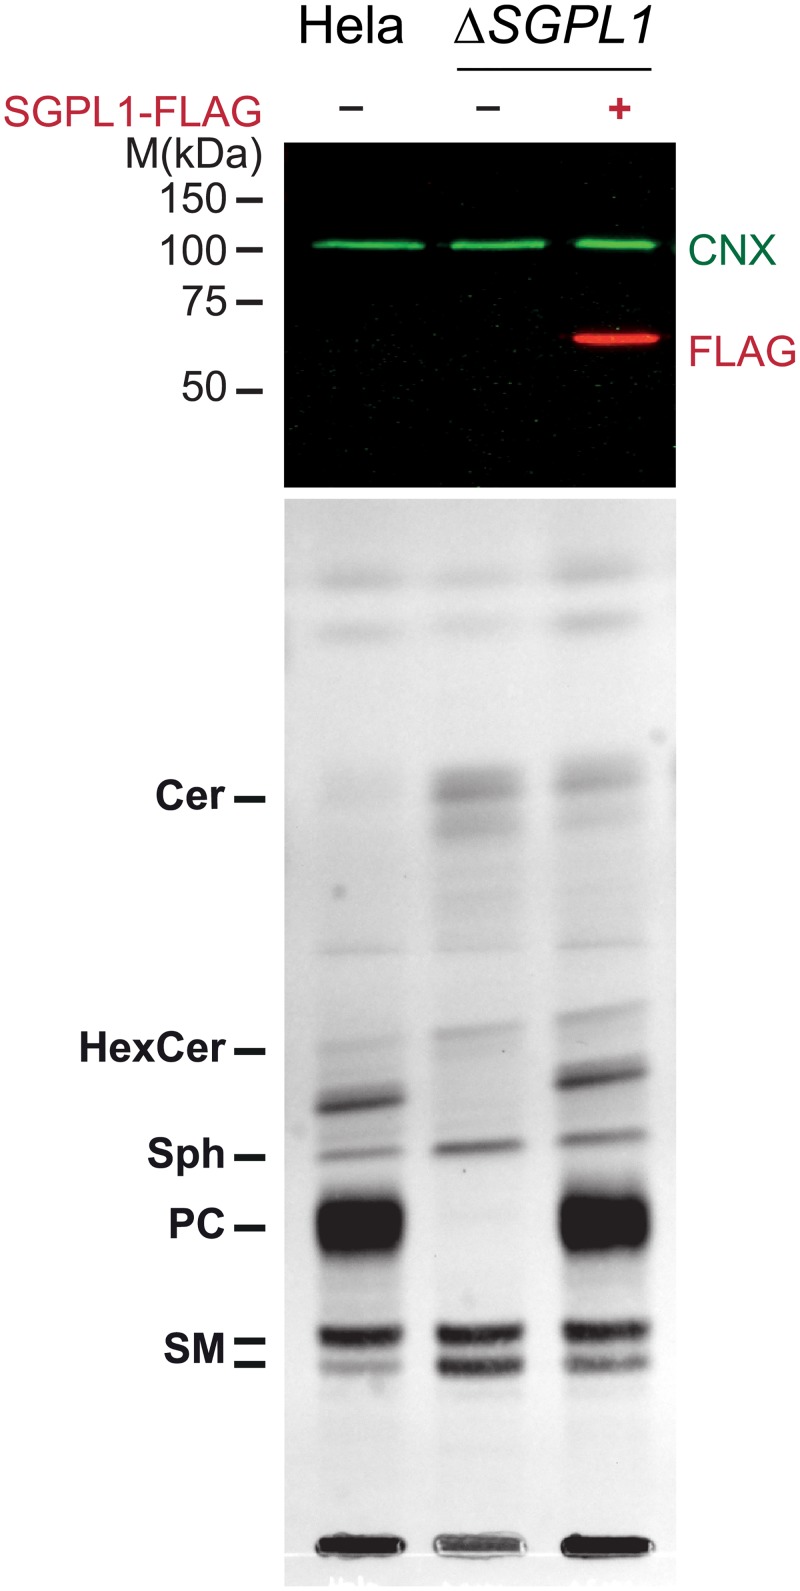
Rescue of HeLa ΔSGPL1 cells by exogenous Flag-SGPL1.HeLa wildtype, HeLa ΔSGPL1 and HeLa ΔSGPL1 transfected with Flag-tagged SGPL1 were labeled with 6 μM pacSph for 4 h. Upper Panel: Proteins precipitated during the lipid extraction were solubilized, analyzed by SDS-PAGE and immunoblotting, using anti-FLAG antibodies (red). Detection of endogenous calnexin with anti-calnexin antibody (CNX, green) was used as a loading control. Lower Panel: Extracted lipids were subjected to click reaction with fluorogenic coumarin azide, separated by TLC and exited with UV light. Lipids were identified via with alkyne lipid standards (S3 Fig).